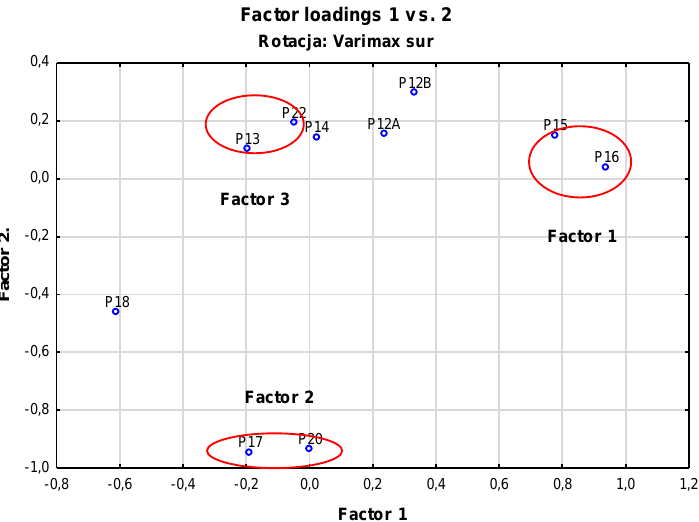
Figure 4. Classification of principal components for question group 12A-22. P13 is under the plane, and P22 is above the plane of the drawing.